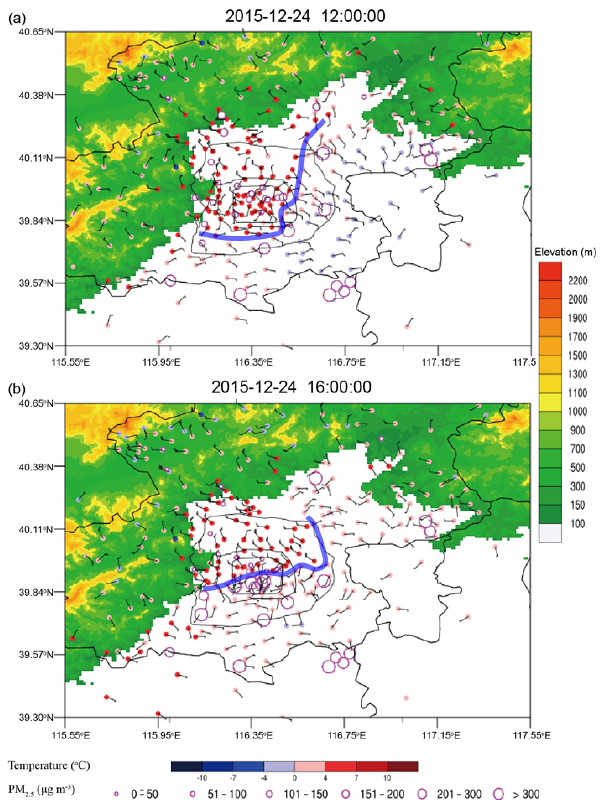
Figure 7. Same as Fig. 6 but with relative